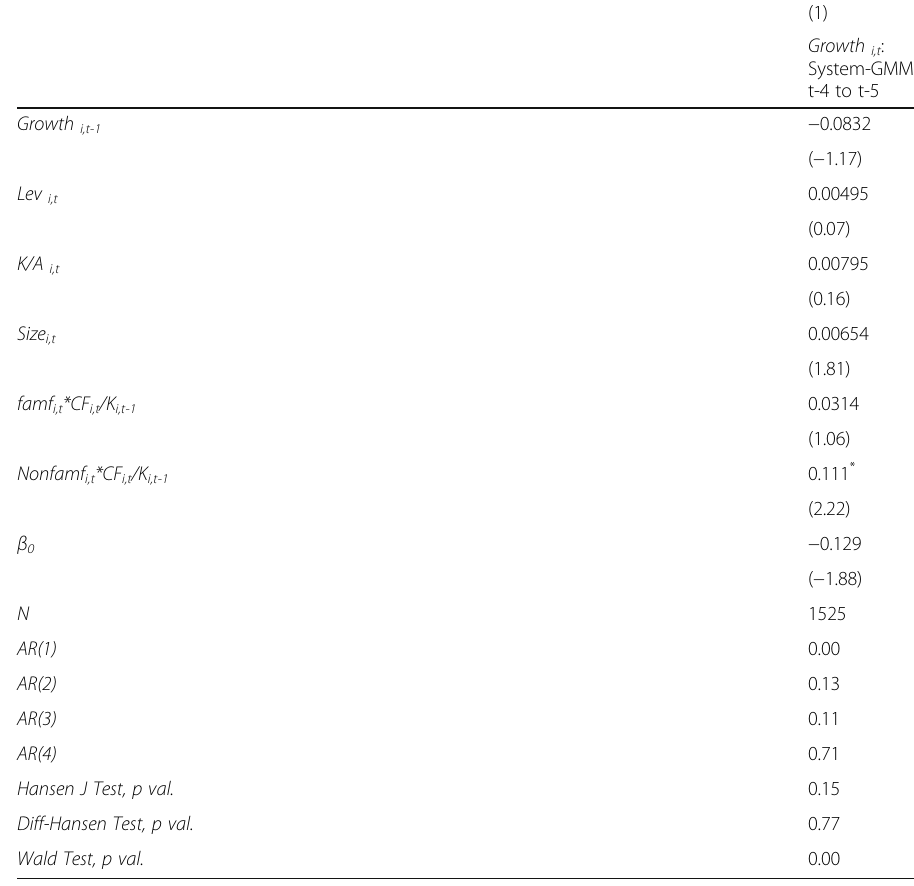
Table 7 System GMM Results for the Main